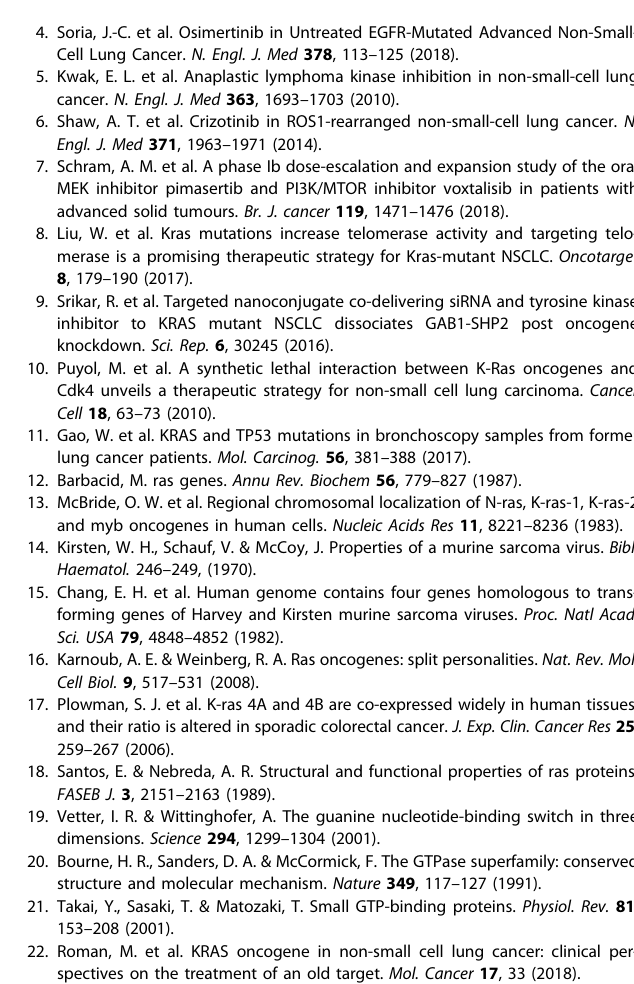
Fig. 7 Acquired resistance mechanism of covalent KRAS (G12C) inhibitors. The fi gure on the left blue background represents cells that are sensitive to KRAS (G12C) inhibitors, while the fi gure on right red background represents cells that are resistant to inhibitors. The black dotted line represents inhibition of KRAS signalling in the presence of KRAS (G12C) inhibitors. The solid red lines represent the resistance mechanisms identi fi ed after the use of KRAS (G12C) inhibitors, including the relief of ERK-mediated feedback inhibition, which reactivates the MAPK pathway by wild-type RAS (NRAS and HRAS) or new synthetic KRAS (G12C); the activation of other bypasses, such as PI3K activation by the IGFR – IRS1 pathway and secondary or additional mutations in KRAS. This fi gure generated from